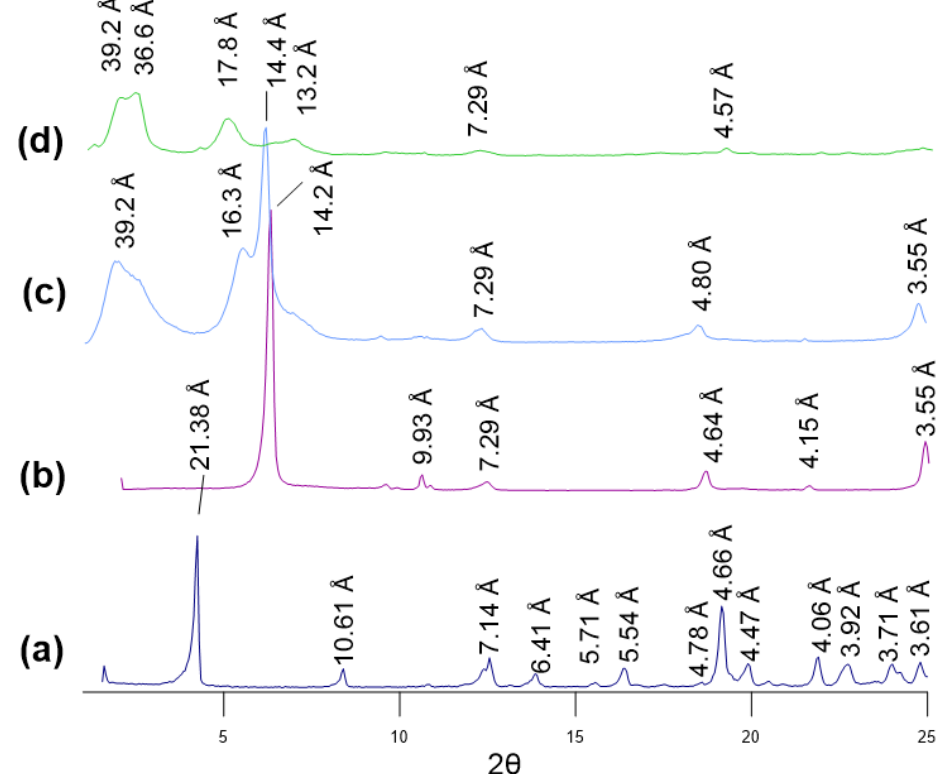
Figure 2. X-ray diffraction patterns of: ( a ) HDBA, ( b ) VER, ( c ) 0.5 HDBA, and ( d ) 2.0 HDBA. Figure 2. X-ray di ff raction patterns of: ( a ) HDBA, ( b ) VER, ( c ) 0.5 HDBA, and ( d ) 2.0